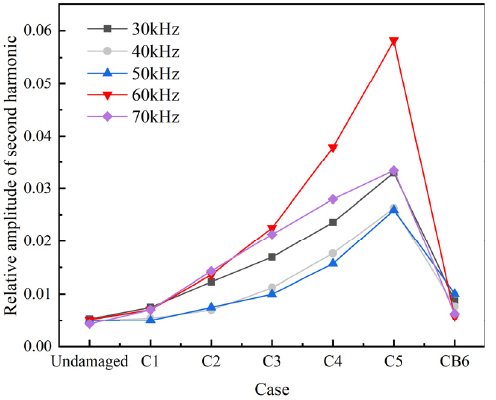
Figure 18. Relative acoustic nonlinear parameter β (cid:48) at different cases.